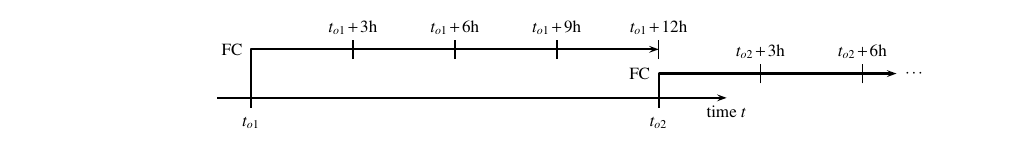
Figure 1. Construction of MACC data times for type FC